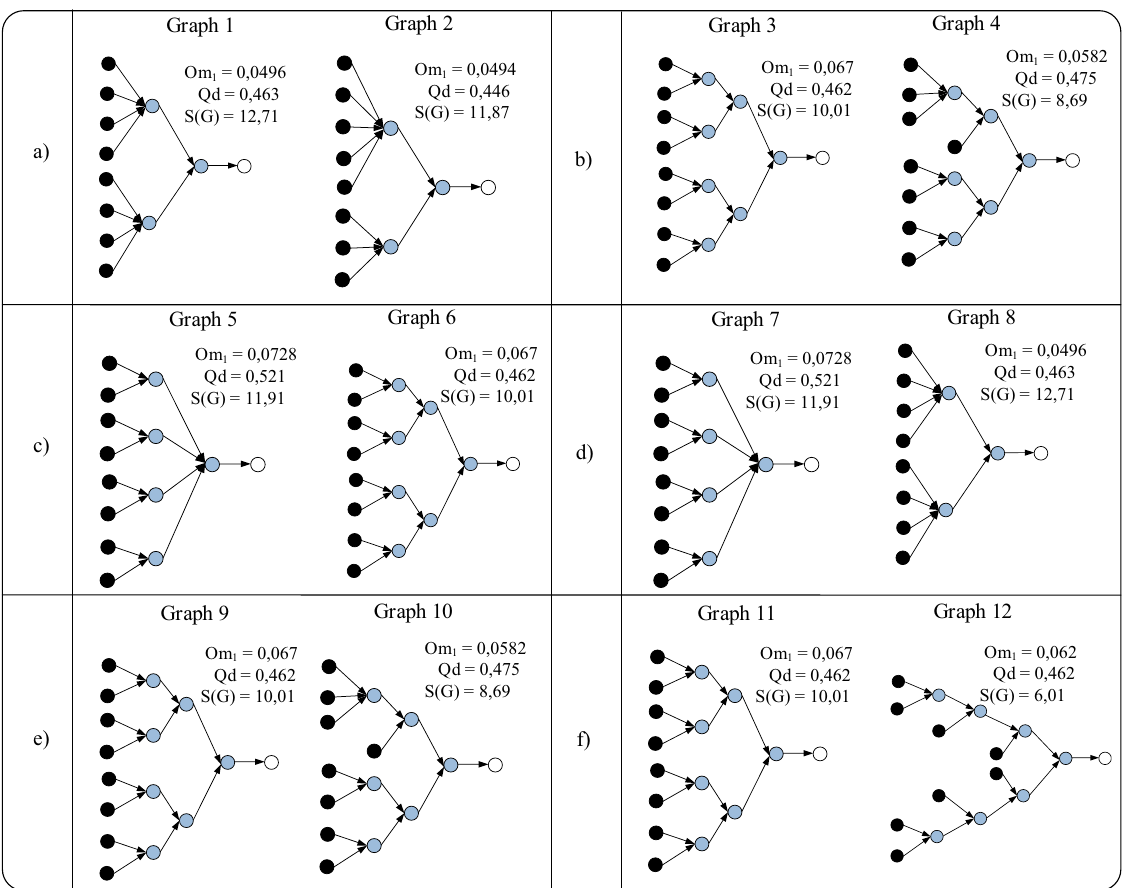
Figure 5. Comparison of the selected alternative ALSs by employing Om 1 and S(G)